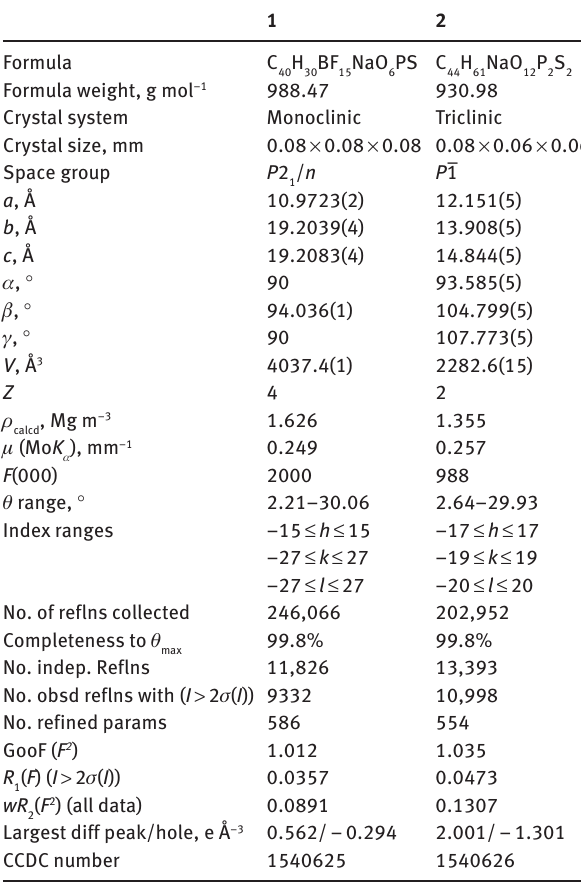
Table 1: Crystal data and structure refinement of 1 and 2